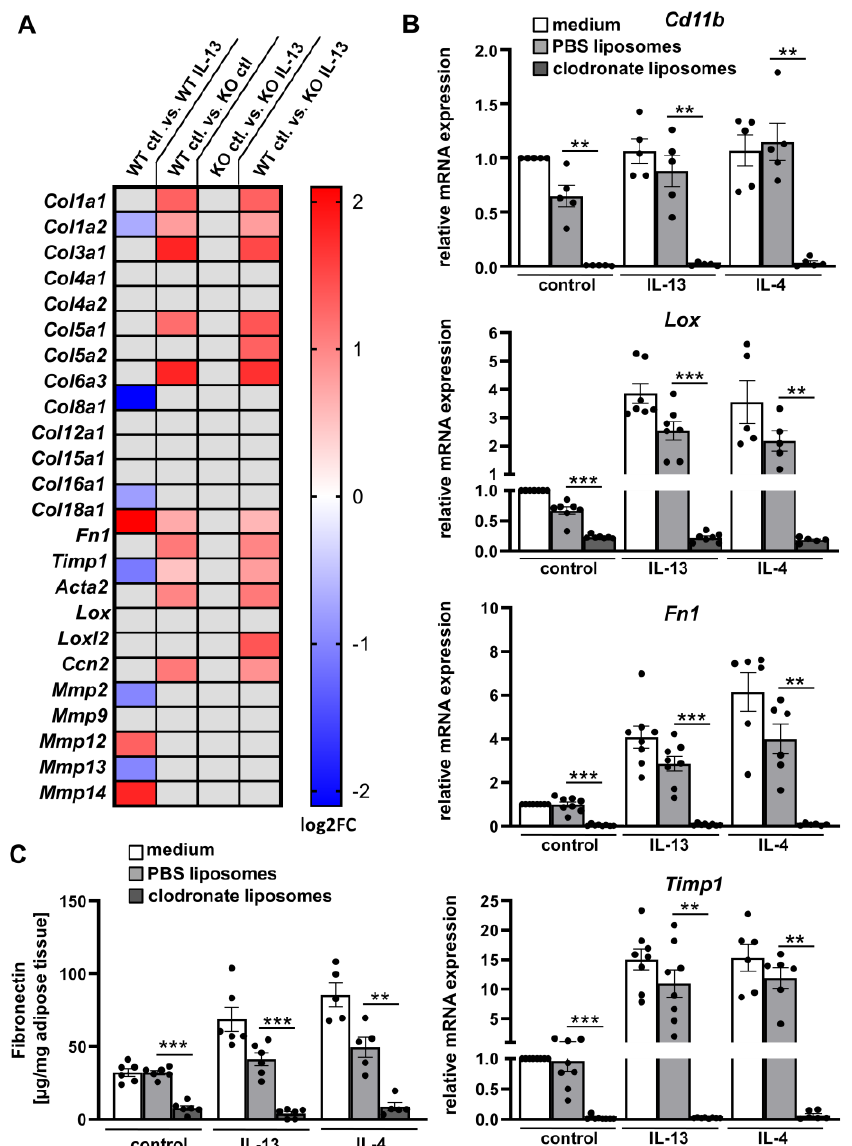
Figure 4. Adipose tissue fibrosis is dependent on adipose tissue macrophages (ATMs). ( A ) BMDMs were isolated from Il4ra − / − mice (KO, n = 4) and Il4ra+/+ littermate controls (WT, n = 4) and stimulated with IL-13 (20 ng/mL) for 48 h. Differential gene expressions (DEGs) were determined from RNA bulk sequencing data and Log2FC of fibrosis-related genes were represented in a heat map; gray boxes illustrate non-significant data (FDR > 0.05) ( B ) Explants from B6J mice (n = 5 – 8) treated with clodronate or PBS liposomes or non-treated (medium) were stimulated for four days with 50 ng/mL IL-13 or IL-4, respectively. mRNA expression of the macrophage marker ( Cd11b ) and fibrosis markers are shown as fold change compared to control conditions (medium, non-stimulated). ( C ) Levels of fibronectin were determined in supernatants of WAT explants (n = 6) by ELISA. All data were represented as mean ± SEM. ** p -value < 0.01; *** p -value < 0.001.